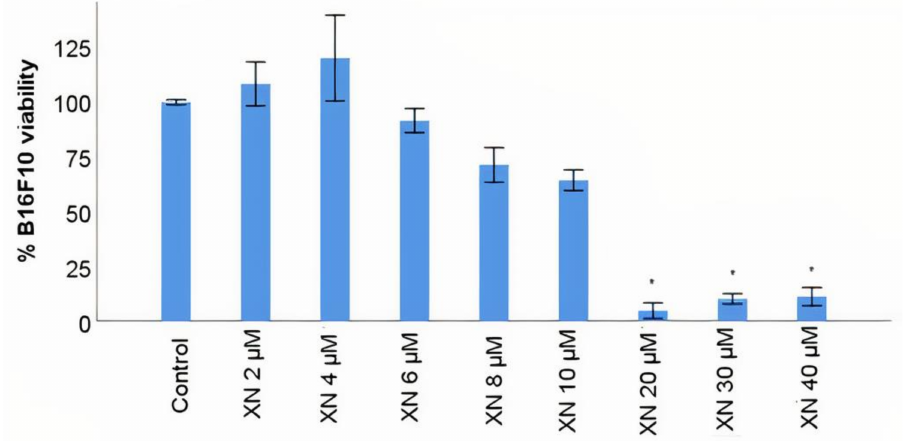
Figure 3. B16F10 viability study with solubilized XN in different concentrations. The control refers to B16F10 incubated with DMEM. “XN” stands for XN. B16F10 viability is expressed in mean percentage ± S.E.M. ( n = 3 for each treatment assay). * Statistically different at a level of p < 0.050 in comparison with the